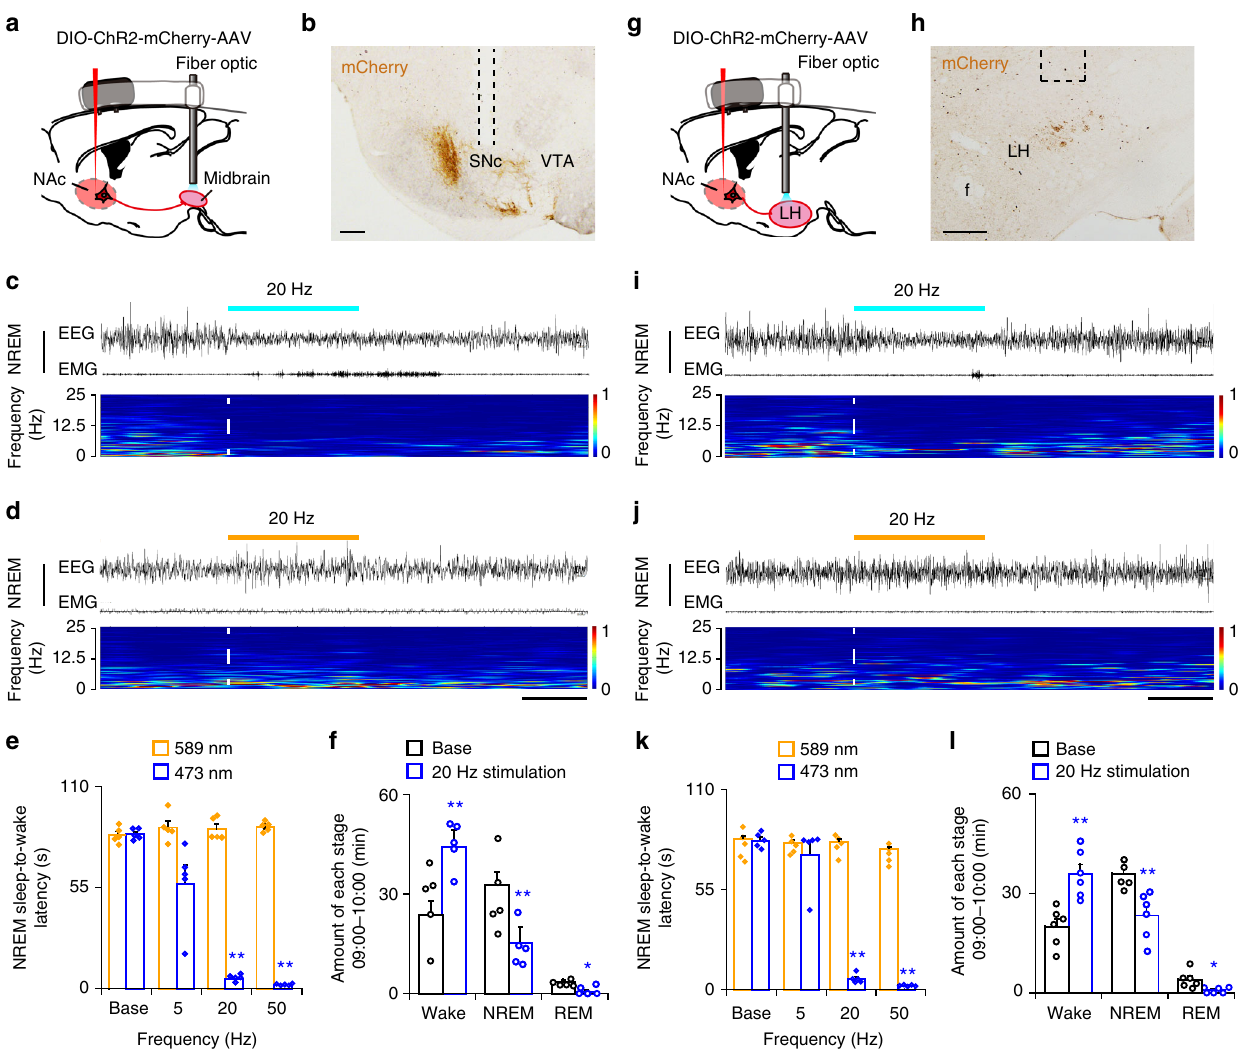
Fig. 6 NAc D 1 R neurons control arousal through midbrain and LH pathways. a , g Schematic diagram showing the location of the optic fi ber in the midbrain ( a ) or LH ( g ), and the implanted somnographic electrodes of a D 1 R-Cre mouse injected with AAV-ChR2-mCherry in the NAc. b , h Sections stained for mCherry showing ChR2-mCherry-positive terminals in the midbrain ( b ) or LH ( h ), and the cannula trace showing the optic fi bers targeting the nuclei. Scale bars: 200 μ m; f fornix. c , i Representative EEG and EMG traces and the corresponding heat map of EEG power spectrum showing that photostimulation in the midbrain ( c ) or LH ( i ) applied during NREM sleep induced a rapid transition to wakefulness. Dashed lines indicate onset of light stimulation. d , j Representative EEG and EMG recordings and the corresponding heat map of EEG power spectrum showing that yellow light stimulation in the midbrain ( d ) or LH ( j ) failed to affect the sleep – wake pattern. Scale bars: 8 s. e Mean latencies of wake transitions during NREM sleep after acute photostimulation at different frequencies ( n = 5, paired t test; Base, t 4 = 0.4, P = 0.7; 5 Hz, t 4 = 2.4, P = 0.08; 20 Hz, t 4 = 28.5, P = 9 × 10 − 6 ; 50 Hz, t 4 = 81.8, P = 1.3 × 10 − 7 ). Data analysis was based on an average of 8 – 12 stimulations per frequency and per mouse. f Total amounts of each stage in the control and 20 Hz photostimulation in the midbrain during 09:00 – 10:00 ( n = 5, paired t test; t 4 = 9.5, P = 7 × 10 − 4 (wake); t 4 = 9.4, P = 7 × 10 − 4 (NREM); t 4 = 3.8, P = 0.02 (REM)). k Mean latencies of wake transitions during NREM sleep after photostimulation at different frequencies ( n = 5, paired t test). Data analysis was based on an average of 8 – 12 stimulations per frequency and per mouse. l Total amounts of each stage in the control and 20 Hz photostimulation in the LH during 09:00 – 10:00 ( n = 6, paired t test). Data represent mean ± s.e.m. * P < 0.05, ** P <